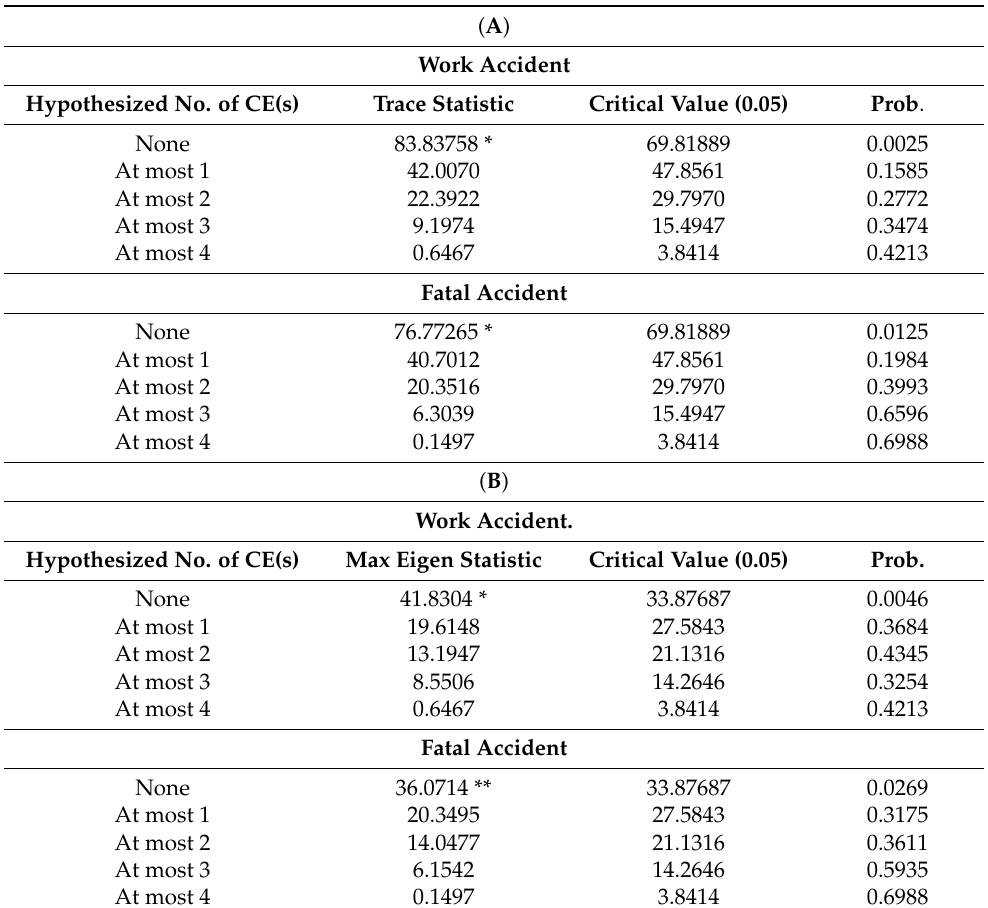
Table 4. ( A ): Unrestricted cointegration rank test (trace). ( B ): Unrestricted cointegration rank test (maximum eigenvalue).